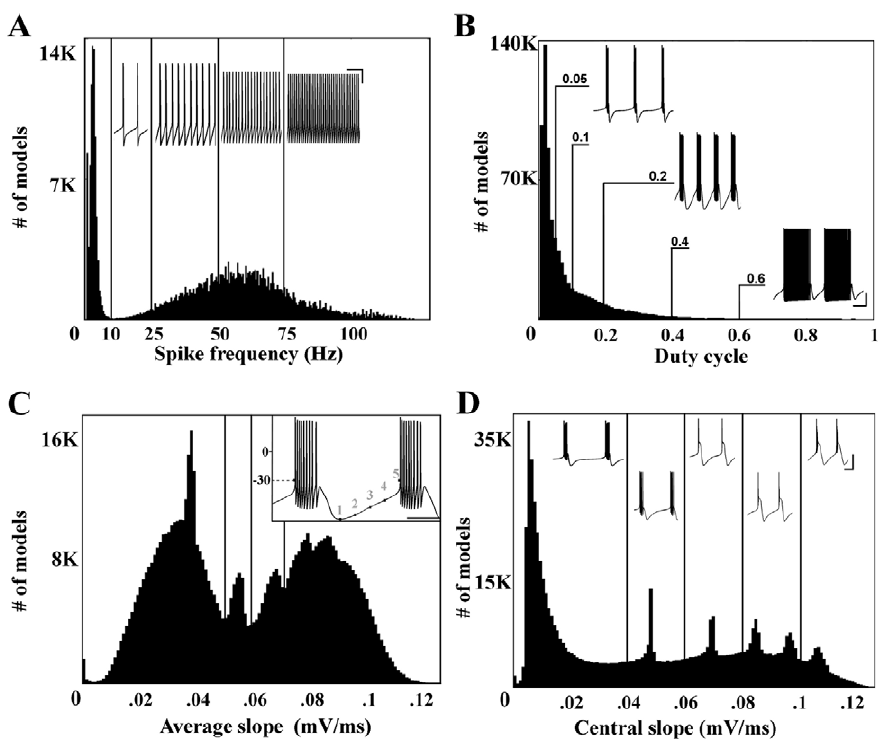
Figure 2. Histograms of main features used for partitioning the database. (A) Periodic intrinsically spiking model neurons sorted by spike frequency. Thin vertical lines indicate group boundaries used for sorting activity type. Voltage traces are for models at the lower bound of each group. Bin size is 0.5 Hz. Scale bars for voltage traces are 20 mV (vertical) and 100 msec (horizontal). (B) Periodic intrinsically bursting model neurons sorted by duty cycle. Labeled lines indicate group boundaries and the duty cycle of adjacent voltage traces. Bin size is 0.01. Scale bars for voltage traces are 20 mV and 500 msec. (C) Periodic bursting models were also sorted by the average slope of the rising phase of their slow wave activity. Inset shows the method of calculation of this slope. Average slope was calculated between points 1 and 4 (see inset), to avoid any artifact generated by the sharp incline of the first spike in the burst. Bin size 0.001 mV/ms. Scale bar for inset is 200 msec. (D) Periodic bursting models were finally sorted by the central slope of the rise phase of the slow wave. Central slope was calculated by taking the average slope between points 2 and 4 seen on the inset in part C. Bin size 0.001 mV/ms. Scale bars for voltage traces are 40 mV and 200 msec.